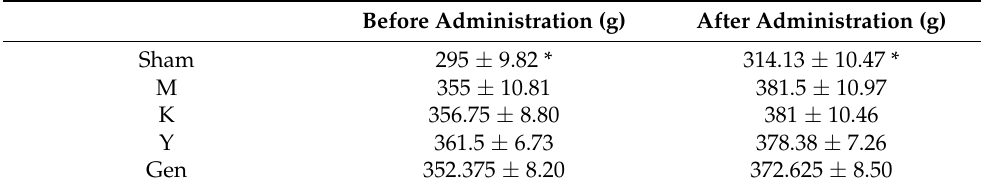
Table 1. Weight change before and after